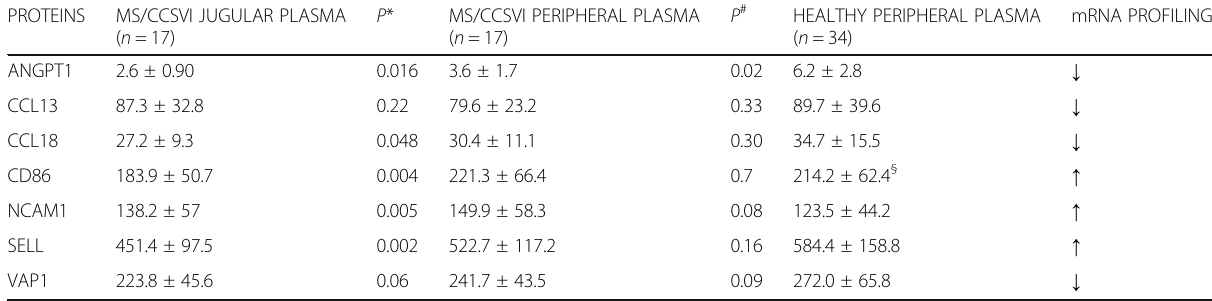
Proteins: ANGPT1 angiopoietin 1, CCL13 chemokine ligand 13, CCL18 chemokine ligand 18, CD86 cluster of differentiation 86, NCAM1 neural cell adhesion molecule 1, SELL selectin L, VAP1(AOC3) vascular adhesion protein 1(amine oxidase copper containing 3). Protein concentrations are reported in ng/ml, except for CD86 (U/ml). All values are expressed as mean ± standard deviation. Arrows indicate up ( ↑ ) or down ( ↓ ) mRNA regulation in MS vs non-MS jugular wall. * P values from paired t-test (MS jugular plasma vs MS peripheral plasma). # P value from t-test on peripheral plasma (MS patients vs healthy subjects). §